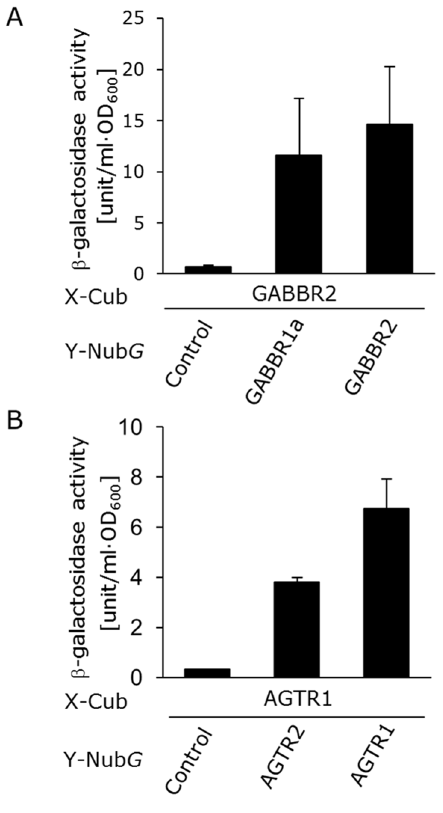
Figure 5. Dimerization assays of human GPCRs. Quantitative b - galactosidase assay. (A) Detection of GABA B1a /GABA B2 (GABBR1a/ GABBR2) heterodimers. (B) Detection of AT 1 /AT 2 (AGTR1/AGTR2) heterodimers. Error bars represent the standard deviations ( n= 3). The control prey plasmid was pPR3-C mock vector.